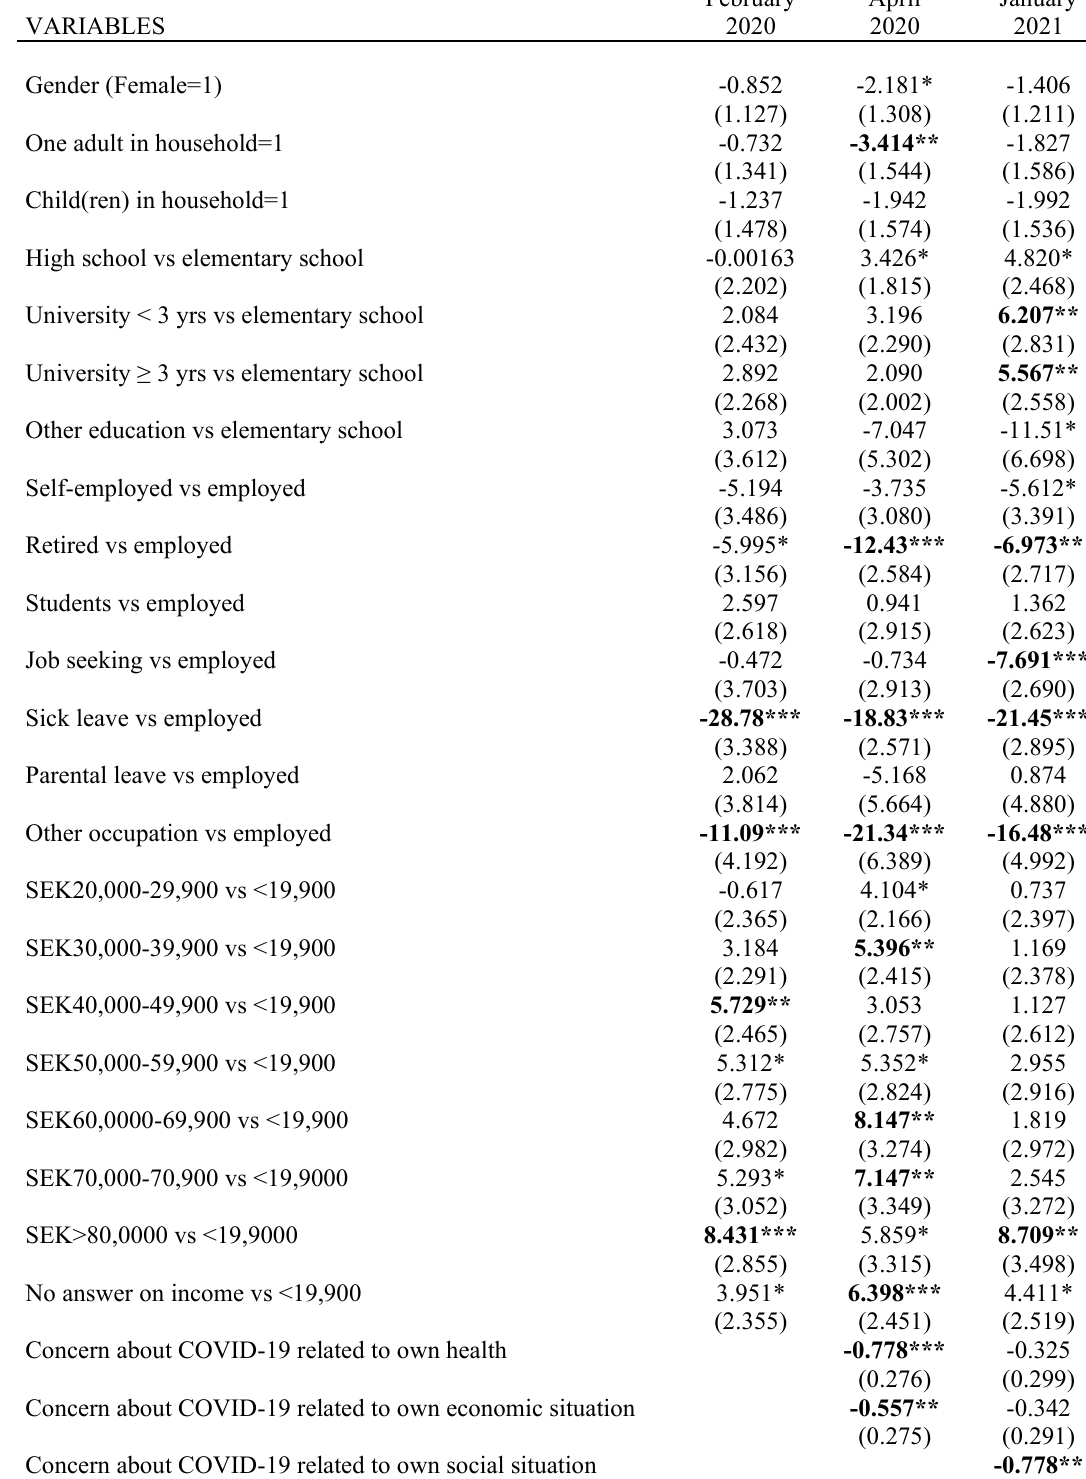
Table 3: Regressions of HRQoL on VAS scale (continued)